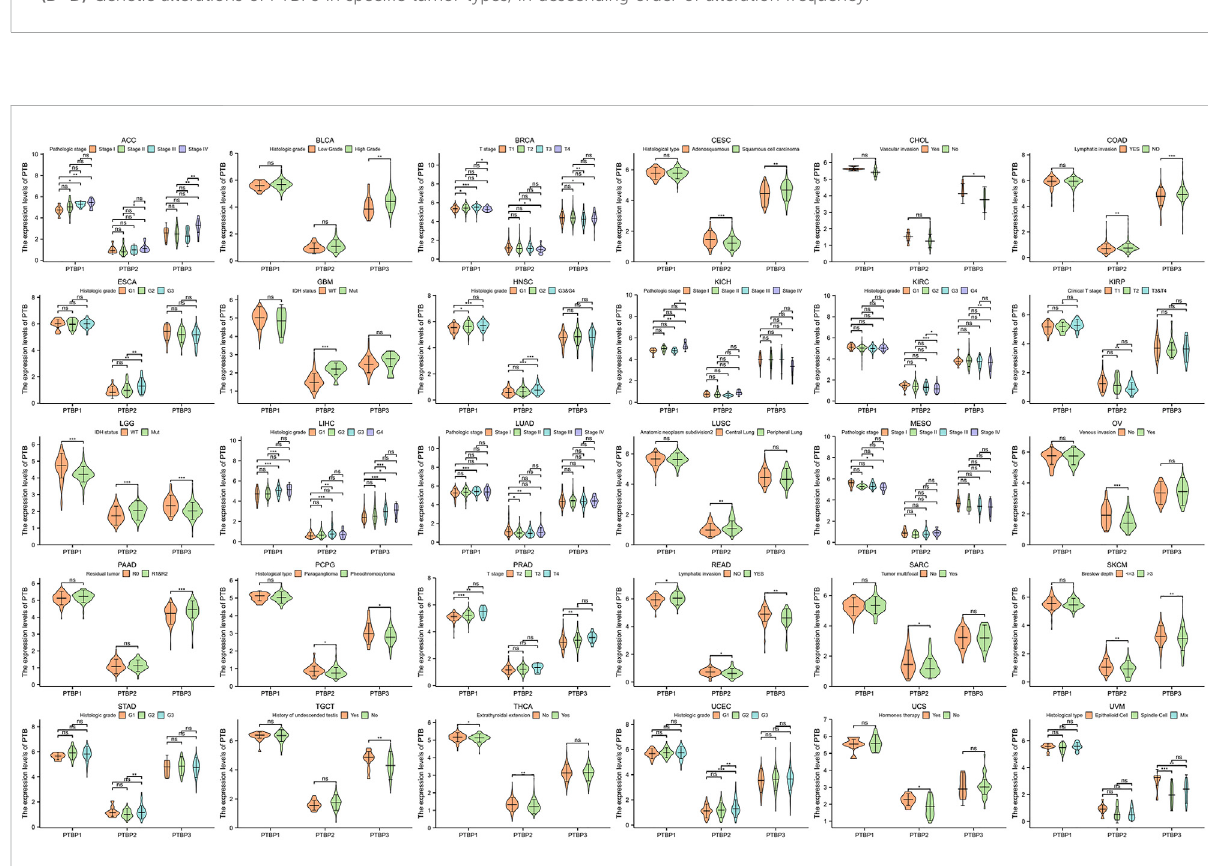
FIGURE 2 Characterization of genetic alterations in PTBPs . (A) General pro fi le of genetic alterations in PTBPs in the pan-cancer dataset from cBioPortal. (B – D) Genetic alterations of PTBPs in speci fi c tumor types, in descending order of alteration frequency.